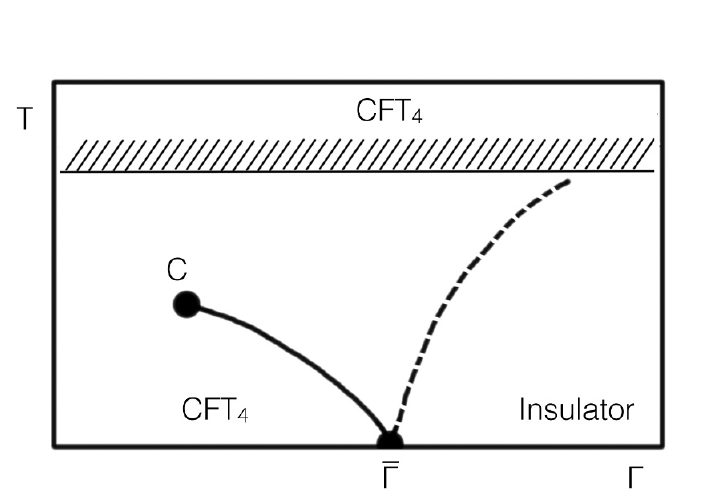
Figure 1 . Schematic phase diagram as a function of the deformation parameter (cid:0) for models with m 2 = (cid:0) 15 = 4, (cid:24) = (cid:0) 1 = 4 discussed in section 5. The T = 0 ground states are RG (cid:13)ows from AdS 5 in the UV, dual to some CFT 4 , to various behaviours in the IR: for (cid:0) < (cid:22)(cid:0) we have AdS 5 (boomerang RG (cid:13)ows), for (cid:0) = (cid:22)(cid:0) we have AdS 2 (cid:2) R 3 (locally quantum critical ground states), and for (cid:0) > (cid:22)(cid:0) we have singular thermal insulating behaviour. There is line of (cid:12)rst order phase transitions that end in the critical point C . Intermediate scaling governed by the AdS 2 (cid:2) R 3 solution is present in the quantum critical wedge bounded by the (cid:12)rst order line and the dashed line. For high temperatures the scaling is (cid:12)xed by the AdS 5 solution in the